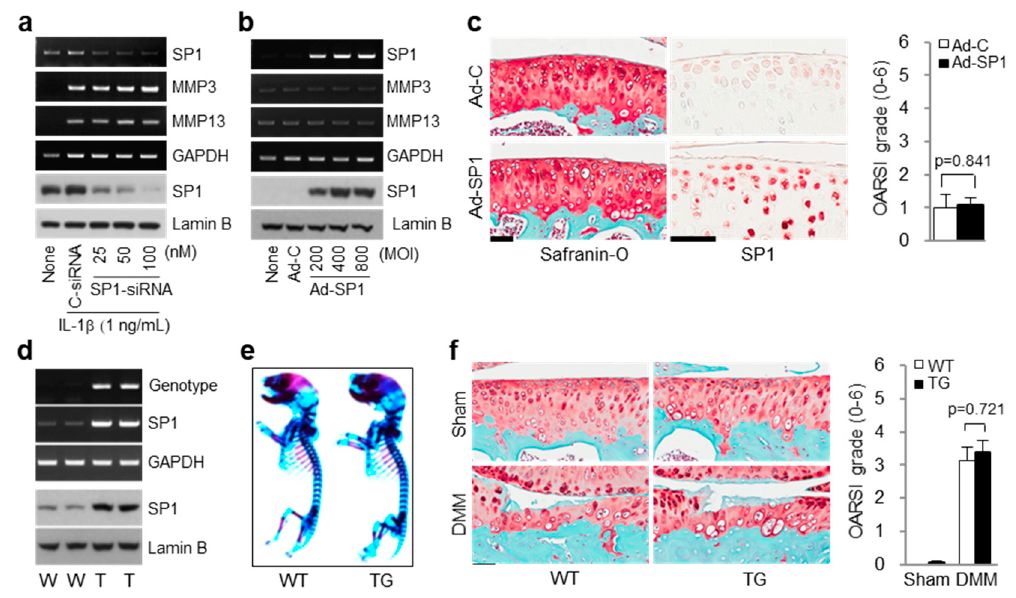
Figure 3. SP1 is not required for MMP induction or OA. ( a ) Effects of SP1 knockdown using SP1 siRNA on MMP expression. mRNA and protein levels of indicated genes were determined by RT-PCR and Western blotting, respectively; ( b ) Overexpression of SP1 in chondrocytes does not induce expression of MMP3 or MMP13. mRNA levels in chondrocytes infected with adenoviral vector coding SP1 (Ad-SP1) with indicated MOI were determined by RT-PCR. Adenoviral vector lacking an insert (Ad-C) was used as a control (800 MOI); ( c ) Representative images of safranin-O staining, SP1 immunostaining, and OARSI scoring of cartilages from mice injected with Ad-C or Ad-SP1 ( n = 5). Values are means ± SEM. Scale bar: 50 μ M; ( d – f ) Effects of SP1 transgenic (TG) mice on OA; ( d ) Characterization of Col2a1-SP1 TG mice and wild type (WT) littermates; ( e ) Skeletal staining at embryonic day 18.5 (E18.5) of SP1 TG mice and their WT littermates; ( f ) Representative images of safranin-O staining and OARSI scoring of cartilages collected from WT and SP1 TG mice operated by DMM surgery ( n ≥ 7). Values are means ± SEM. Scale bar: 50 μ M.